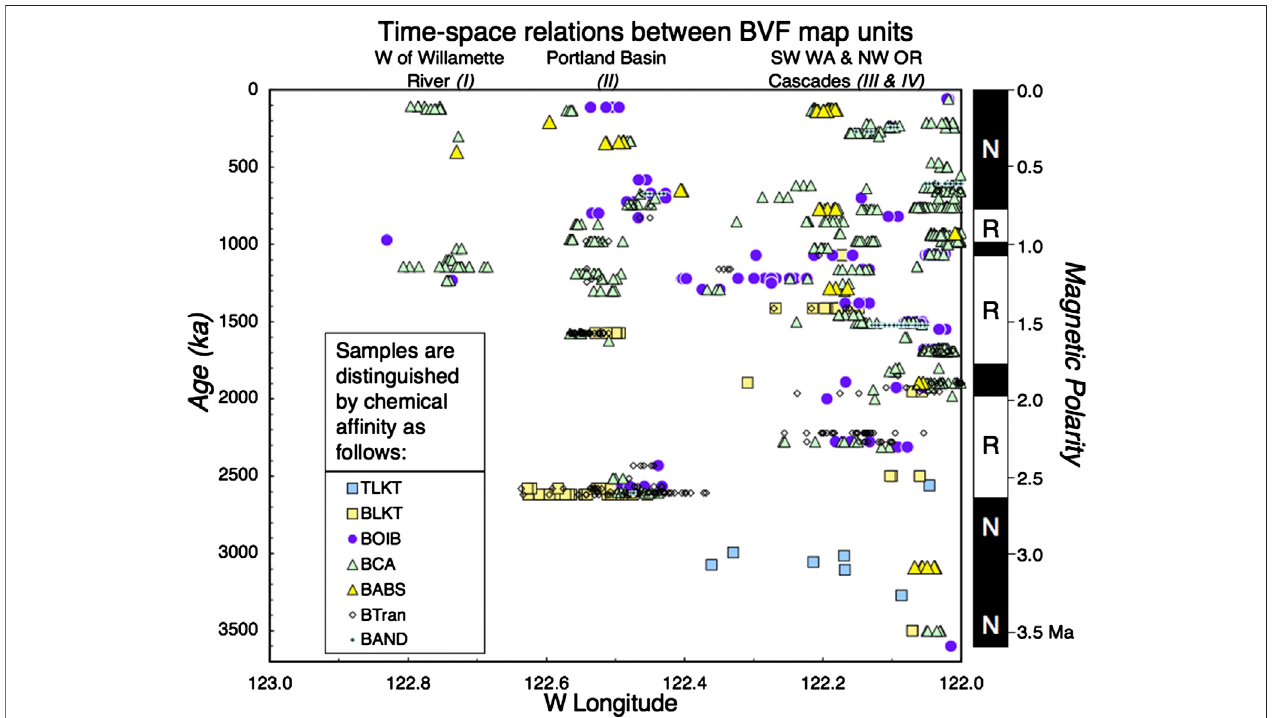
FIGURE 9 | Distribution of magma types over time in western sectors of the Cascades Columbia Transect (CCT) proximal to Portland Basin (Fleck et al., 2014; Hagstrum et al., 2017; Leeman et al., 2019). Local eruptions in the Portland Basin area initiated as early as ∼ 2,600 ka and have continued intermittently to ∼ 50 ka. LKT activity was restricted to the early history of the fi eld, whereas other magma types erupted from the onset to the near-present.